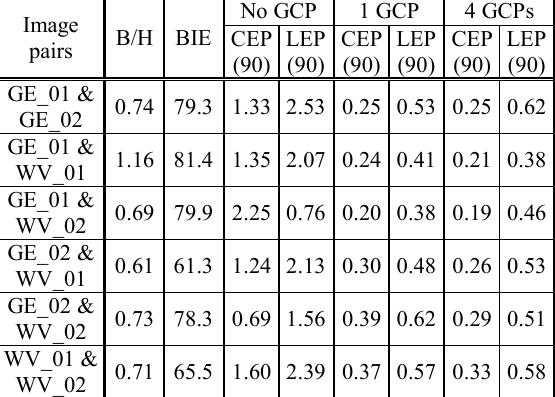
Table 3. Accuracy of Stereo